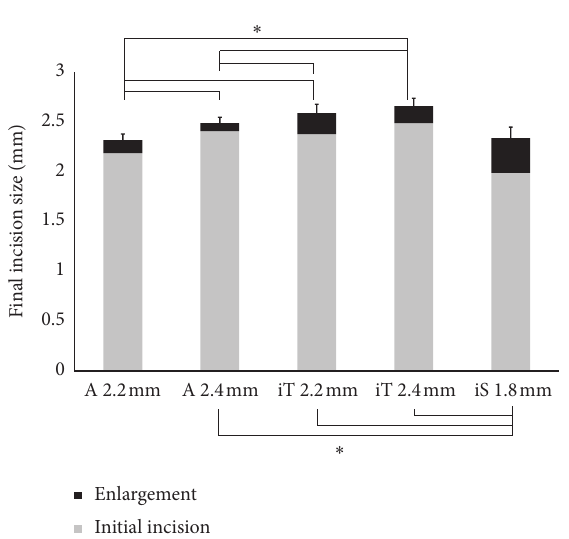
Figure 4: Mean final incision size (initial incision size +enlarge- ment) with sclerocorneal incisions ( ± SD) ( ∗ P < 0 . 05, one-way analysis of variance) (A � AutonoMe; iT � iTec; iS �